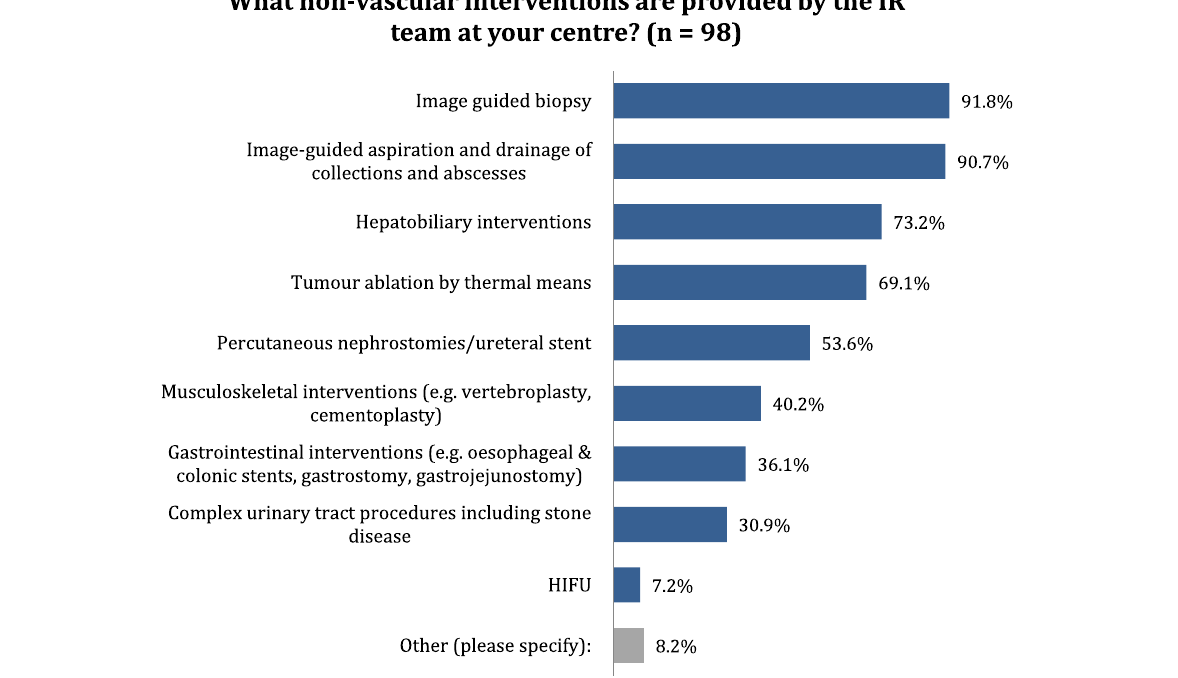
Fig. 4 Distribution of answers to question 28: What non-vascular interventions are provided by the IR team at your